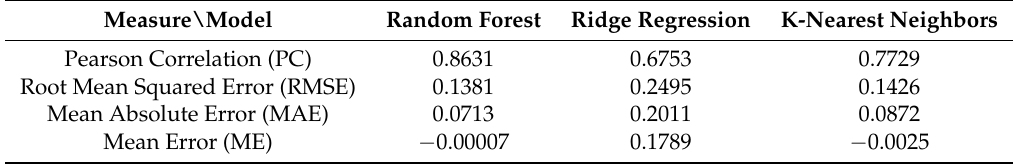
Table 7. Measures of error and quality from models trained with both SDSS features and SpArcFiRe features. Note that these three models were each simultaneously trained from scratch on exactly the same data for this comparison, and thus the RMSE and Pearson correlations—which depend upon stochastic parameters—of this particular random forest (RF) model differs from our RF model discussed in the rest of the paper.